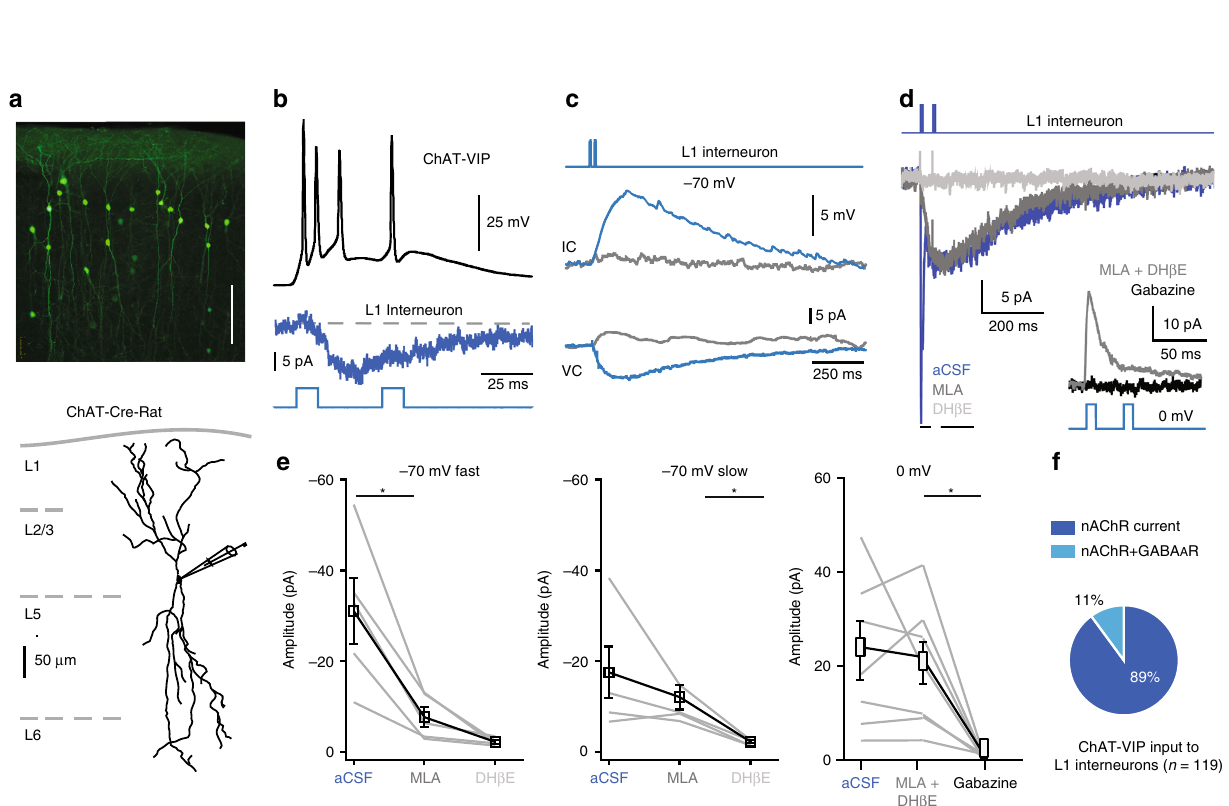
Fig. 2 ChAT-VIP interneurons release ACh and GABA. a EYFP-labelled ChAT-VIP interneurons in rat mPFC. Labelled cells in L2/3 have bipolar morphology (scale bar 200 μ m). Below: Digital reconstruction of an EYFP-positive ChAT-VIP interneuron in the rat mPFC. b Response to blue-light-induced ChR2 activation (470 nm, 10 ms, 25 Hz) of a rat mPFC ChAT-VIP neuron (black trace, top panel, voltage response). Middle blue trace: postsynaptic response in a simultaneously recorded L1 interneuron. Bottom: blue-light stimulation protocol applied. c L1 interneuron is depolarized by blue-light ChR2-mediated activation of ChAT-VIP cells. A single component inward current underlies the depolarization. Both the inward current and the depolarization are blocked by nAChR blockers (MLA 100 nM and MEC 10 µ M, grey traces). d L1 interneuron recording showing light-evoked biphasic synaptic input currents at − 70 mV in aCSF (blue trace). In the presence of MLA (100 nM), the fast component is selectively blocked (dark grey trace). Adding DHßE (10 µ M) blocked the slow component (light grey trace). Inset: L1 interneuron recording at 0 mV showing light-evoked synaptic currents in the presence of nAChR blockers (grey trace) or gabazine (10 µ M, black trace). e Summary plots of pharmacology of postsynaptic responses in L1 interneurons in response to light- induced ChR-mediated activation of ChAT-VIP neurons. Left panel: amplitudes of fast postsynaptic currents at − 70 mV in aCSF and with nAChR blockers MLA and DHßE (aCSF: − 30.92 ± 7.24 pA, MLA: − 7.68 ± 2.21 pA, p = 0.014, paired t -test, two-tailed, t = 3.888, df = 4, n = 5). Middle panel: amplitudes of slow postsynaptic currents at − 70 mV in aCSF and with nAChR blockers MLA and DHßE (aCSF: − 17.47 ± 5.71 pA, DHßE: − 2.31 ± 0.40 pA, p = 0.015, paired t -test, two-tailed, t = 3.888, df = 4, n = 5). Right panel: amplitudes recorded at 0 mV (aCSF: 20.18 ± 5.794 pA, nAChR blockers: 22.77 ± 7.932 pA, gabazine: 1.803 ± 0.6177 pA, one-way ANOVA: F (6,12) = 2.256, p = 0.0220, n = 7). Summary plots show averages ± SEM. f Incidence of L1 interneurons in rat mPFC receiving nAChR and GABA A R-mediated synaptic inputs from ChAT-VIP